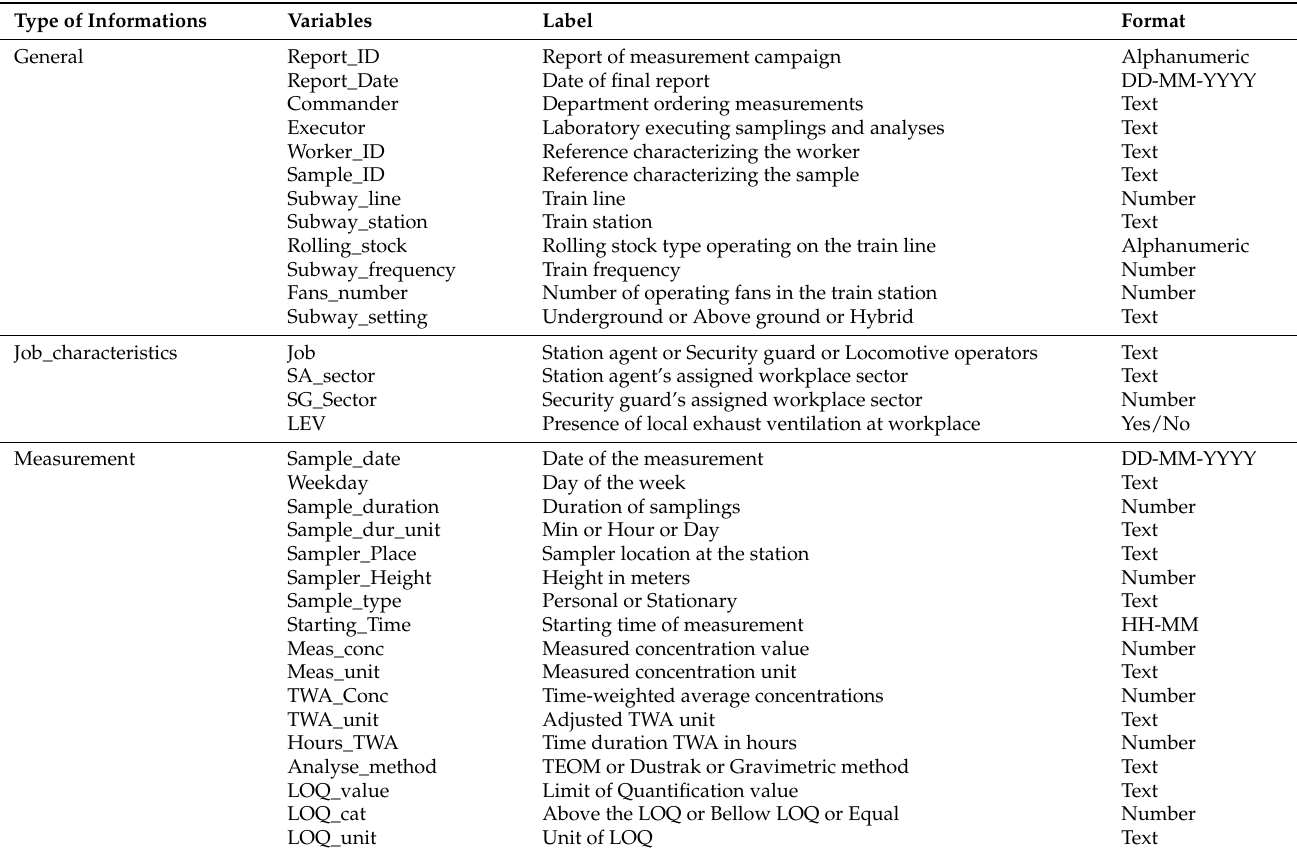
Table 1. Variables included in the Subway-PM